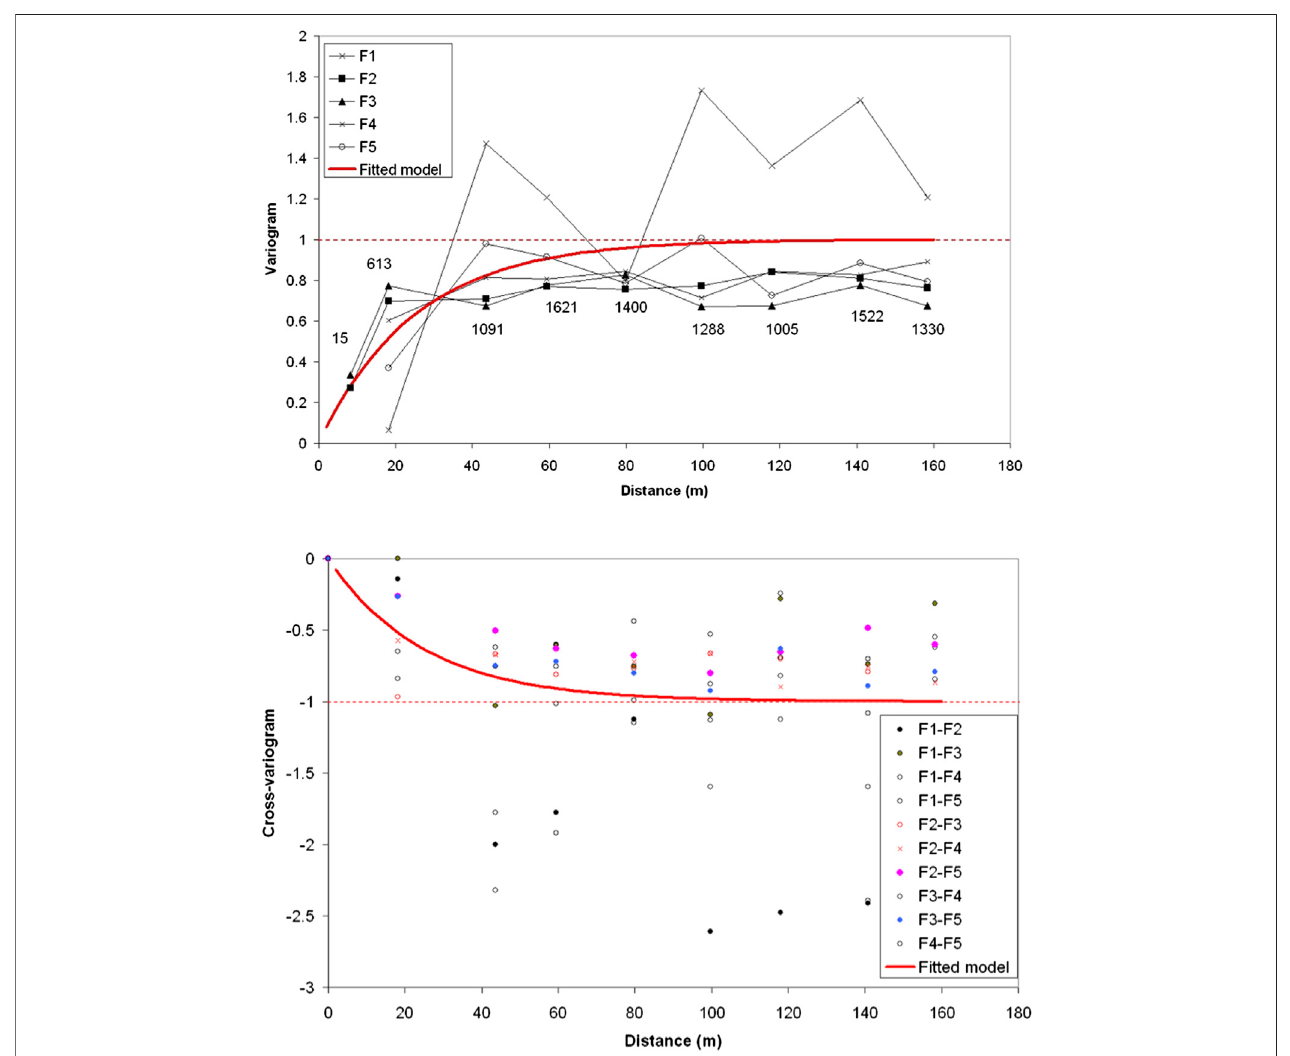
FIGURE 8 | (A) Standardized indicator direct variogram for the fi ve hydrofacies and fi tted model. (B) Standardized indicator cross-variograms for the fi ve hydrofacies: ten cross-variograms and fi tted model. The fi tted model isan intrinsic model ofcoregionalization. The model isexponential with range 25 m (effective range of 75